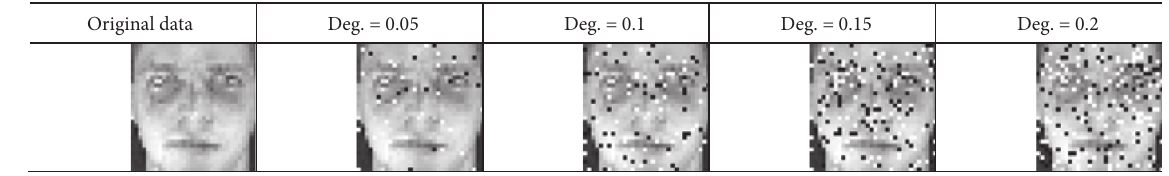
Figure 3: Example of the original image and corrupted one with different degree of noise on the ORL dataset. Table 2: Clustering results concerning the accuracy of different algorithms on the ORL dataset.